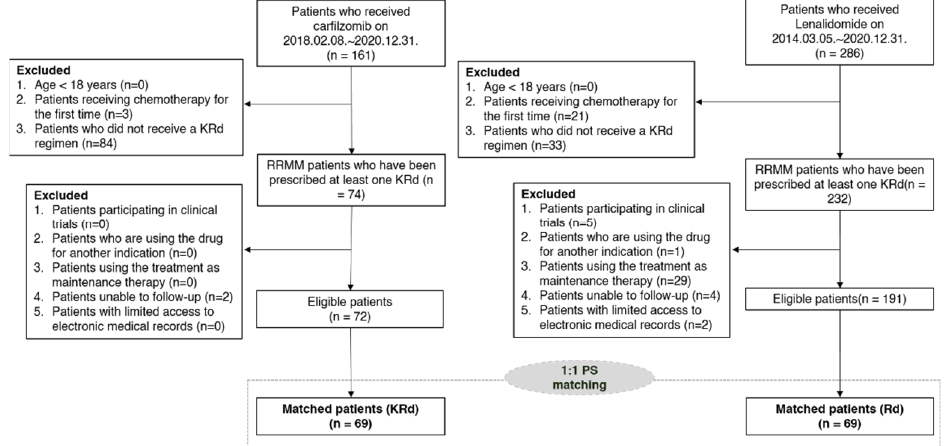
Figure 2. Flow chart showing experimental design. KRd—combination regimen of carfilzomib, lenalidomide and dexamethasone; PS—propensity score; Rd—combination regimen of lenalidomide and dexamethasone. Table 1. Baseline characteristics.